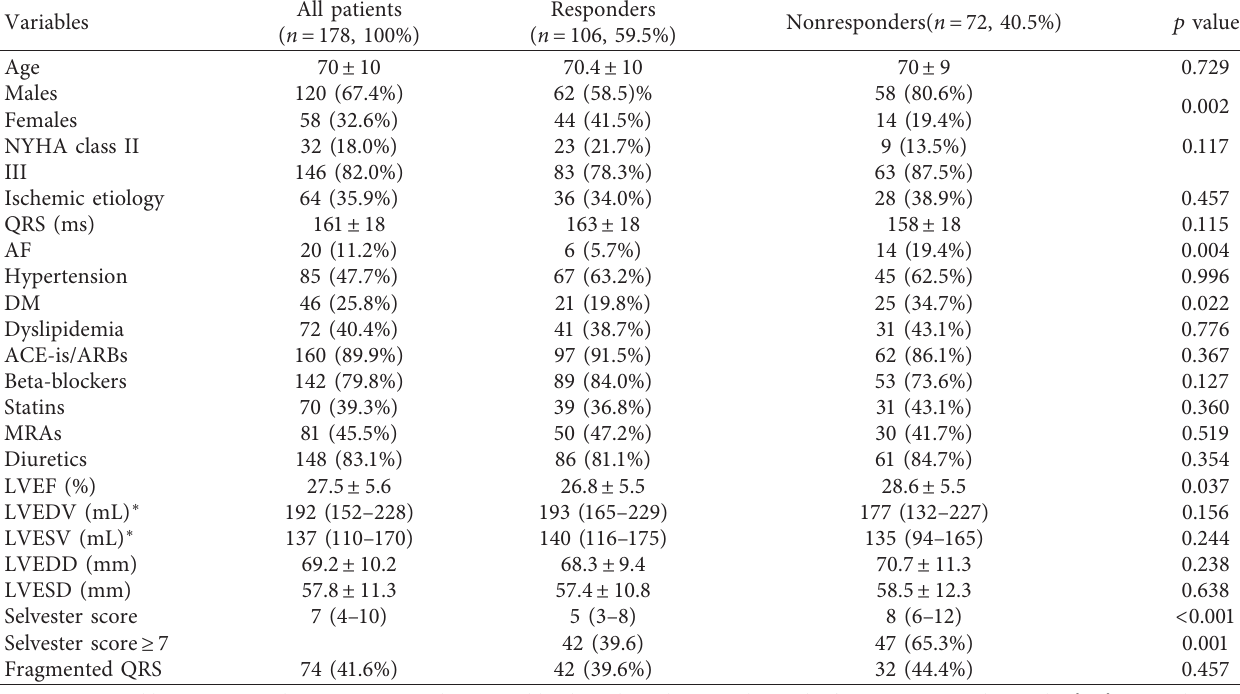
Table 2: Population baseline characteristics and distribution between responders and nonresponders.